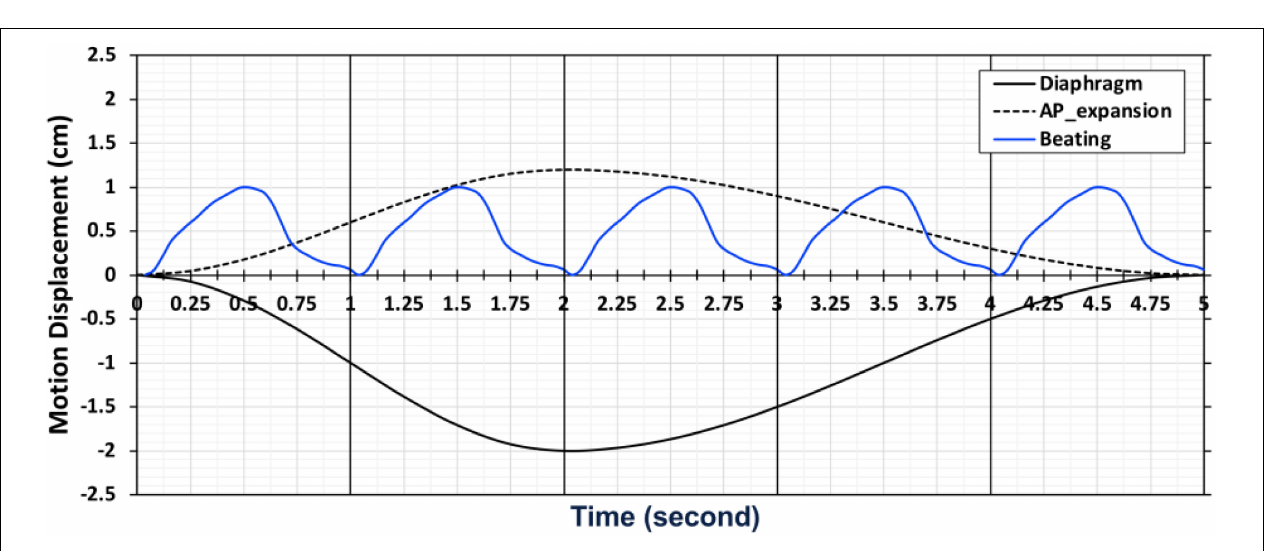
FIGURE 2 | A chart depicting the motion of cardiac and respiratory series for 40 phantoms with 5 cardiac and 1 respiratory cycle from end-inhalation to